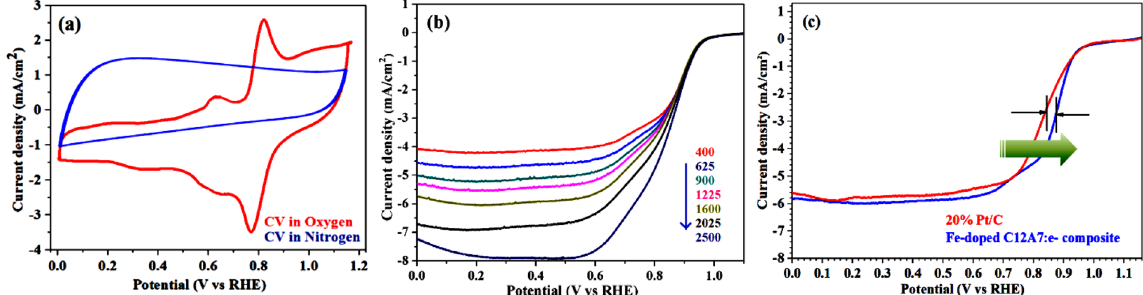
Figure 8. ( a ) CVs curves with a scan rate 50 mV·s − 1 under O 2 saturated 0.1 M KOH solution, ( b ) LSV/ curves with a scan rate 10 mV/s, (c) ORR polarization curves of Fe-doped C12A7:e − composite, and Pt/C, in O 2 - saturated 0.1 M KOH, with 1600 rmp, and 10 mV/s scan rate.